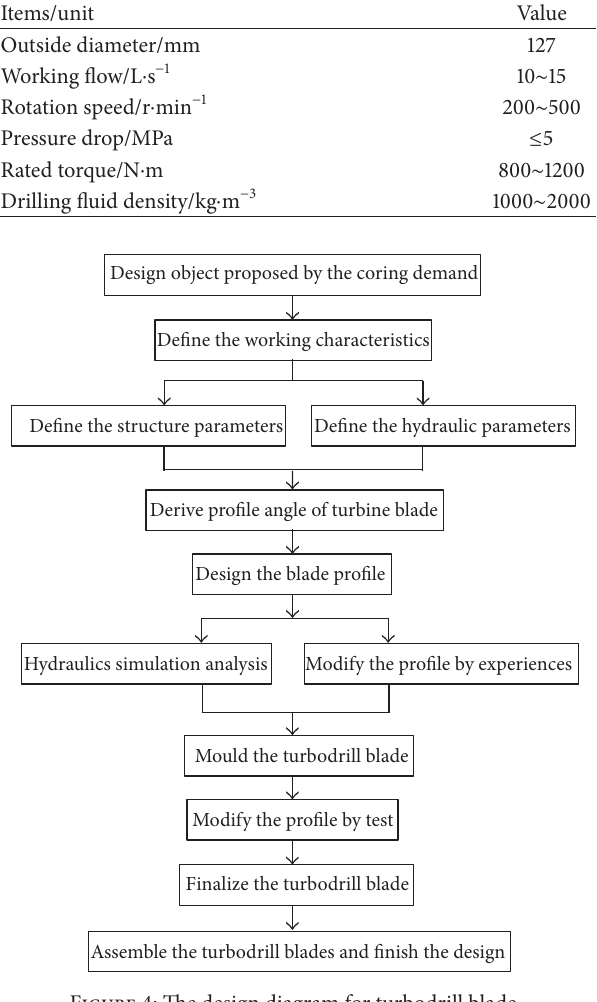
Figure 4: The design diagram for turbodrill